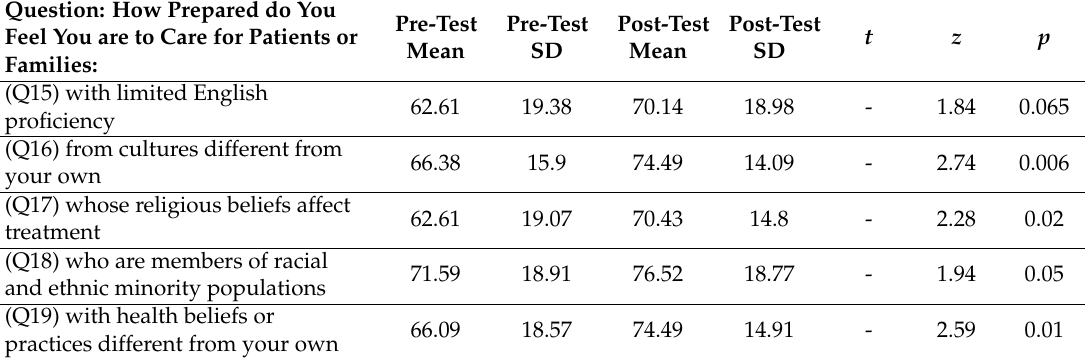
Table 4. Provider preparedness a,b .